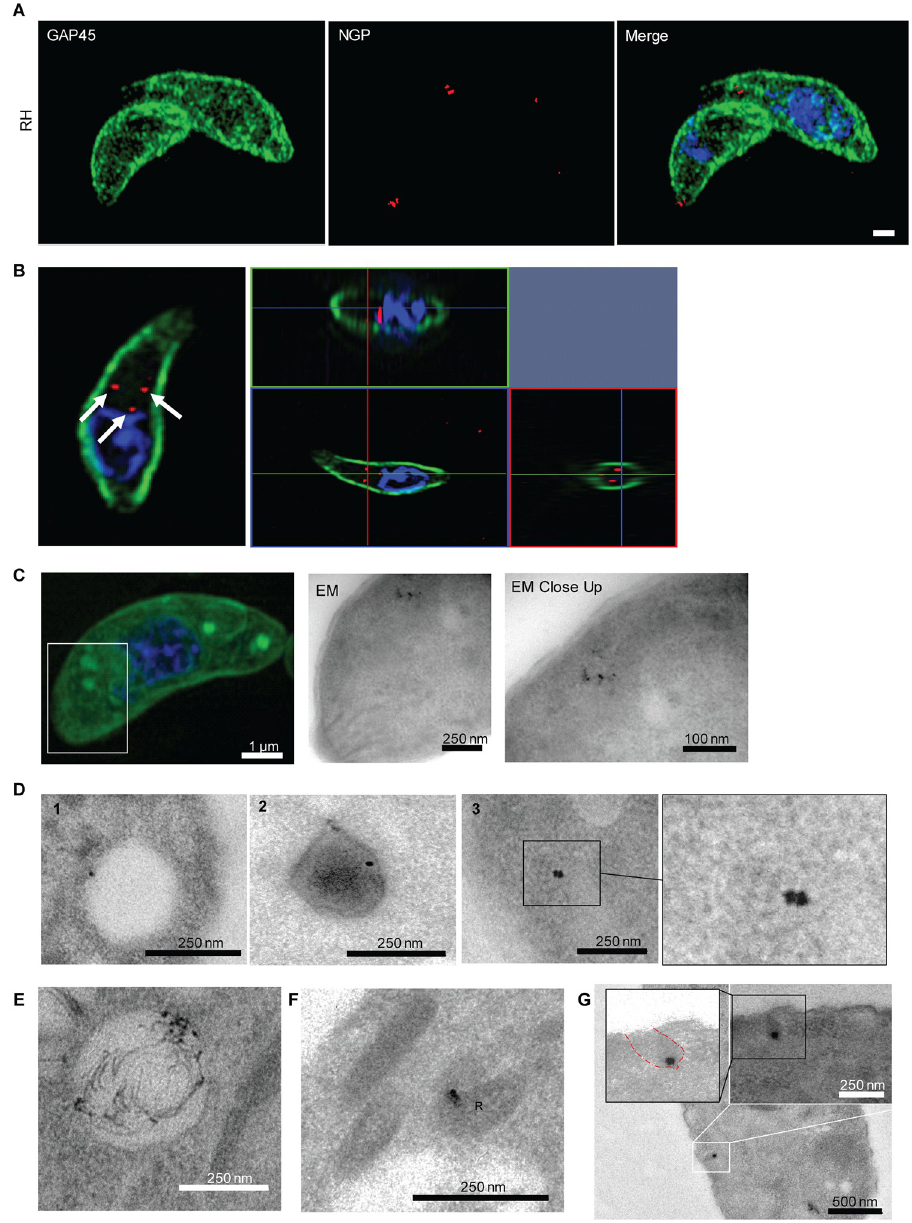
Fig 5. NGPs are taken up by T . gondii . (A-B) Uptake of NGPs was tested on RH- and RH Tf-LPA–treated parasites with 10- μ m Cy5 conjugated gold beads. Parasites were imaged using 3D-SIM microscopy. NGPs were found to accumulate below GAP45, as illustrated by either maximum intensity projection (A) or ortho-view (B). Scale bar, 1 μ m. (C) CLEM imaging of Tf-LPA and NGP uptake. After the uptake experiment, parasites were imaged using super-resolution microscopy (scale bar, 1 μ m) before imaging by EM to evaluate if NGPs and Tf-LPA are inside the same vesicles. White square: close-up illustrated by the first TEM image; black square, TEM close-up. (D-G) TEM localisation of NGP. Scale bar size is indicated on the images. (D) Representative images of the different types of vesicles observed: (1) large translucent vesicles (300–500 nm), (2) medium-sized dense vesicles (215–375 nm), and (3) small vesicles (80–200 nm). (E) Localisation of the NGPs in the VAC, (F) localisation of the NGPs in rhoptry bulbs (labelled with R) by TEM. (G) Image of a potential entry point as an invagination of the plasma membrane containing NGP. CLEM, correlative light and electron microscopy; EM, electron microscopy; NGP, nanogold particle; TEM, transmission electron microscopy; Tf-LPA, Top-Fluor lysophosphatidic acid; VAC, vacuolar-like compartment; 3D-SIM, three-dimensional structure illumination